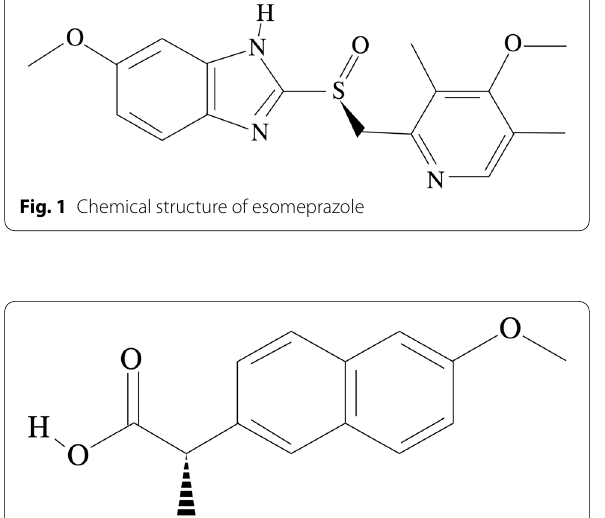
Fig. 2 Chemical structure of